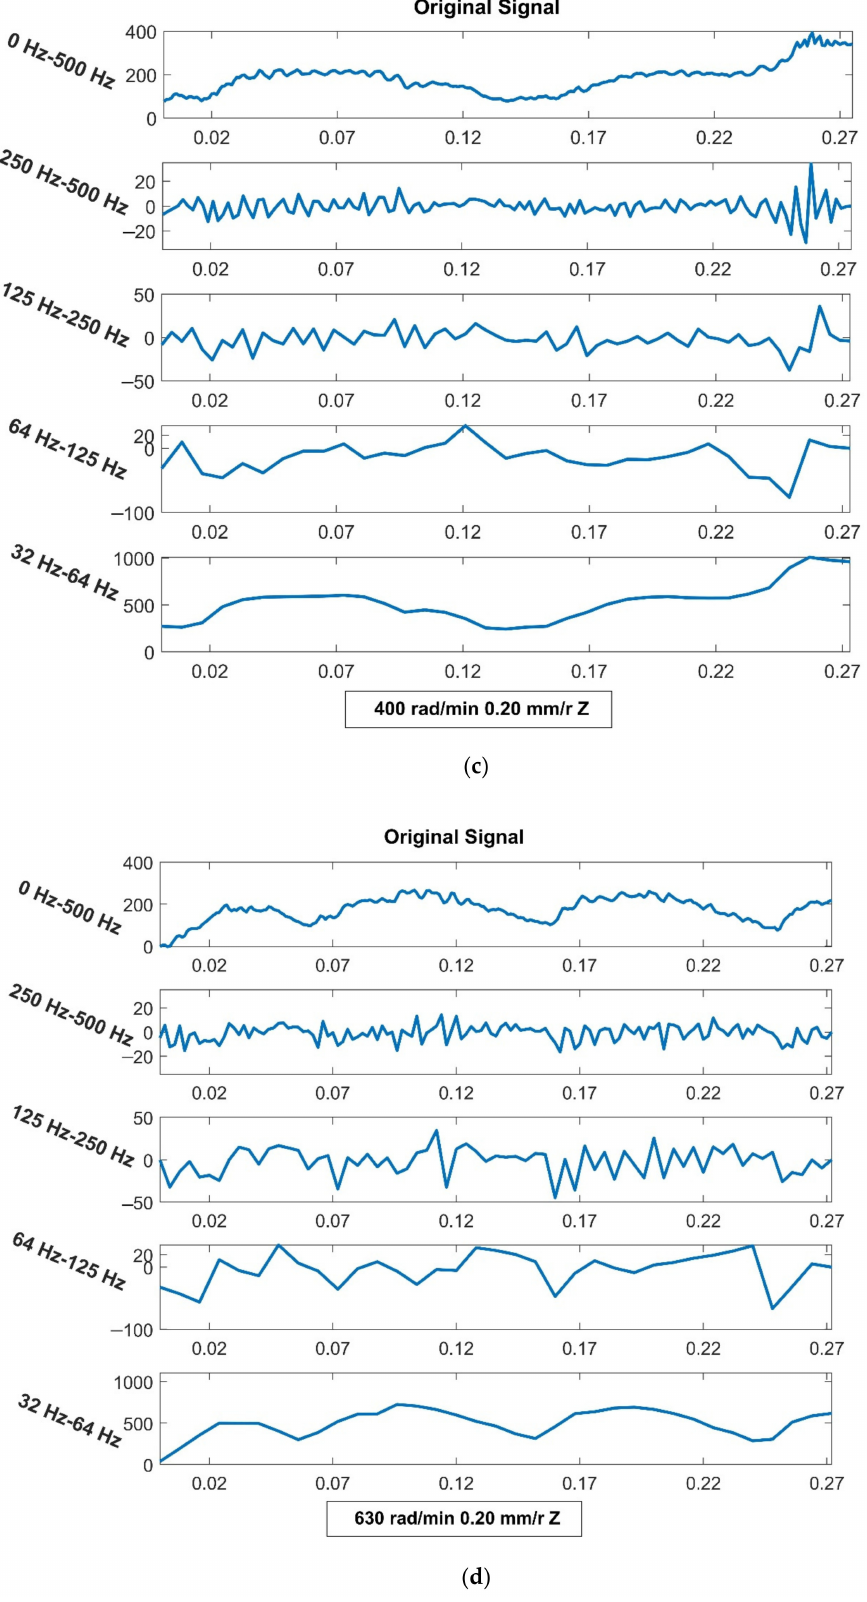
Figure 14. Results of wavelet analysis in the Z-direction when the feed rate is 0.20 mm/r and the rotational speed is different. ( a ) The rotational speed is 100 rad/min. ( b ) The rotational speed is 200 rad/min. ( c ) The rotational speed is 400 rad/min. ( d ) The rotational speed is 630